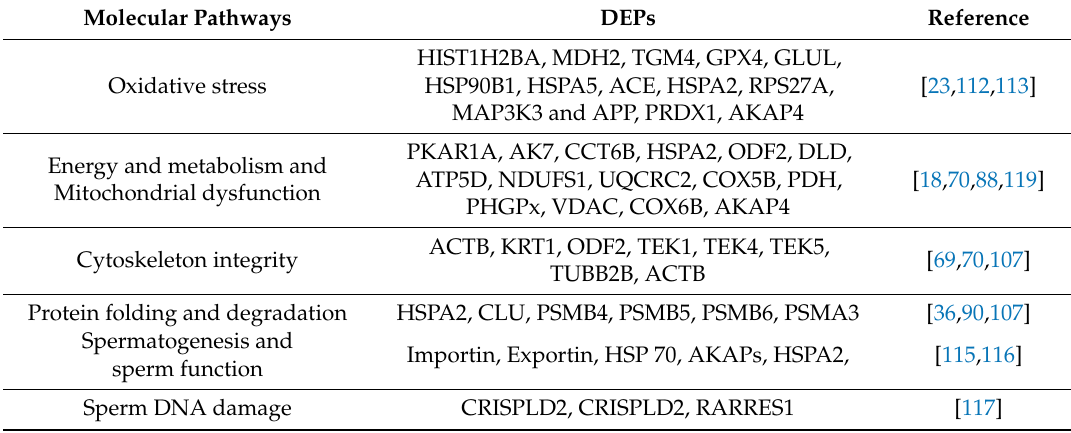
Table 2. DEPs involved in the functional pathways implicated in male infertility. Molecular